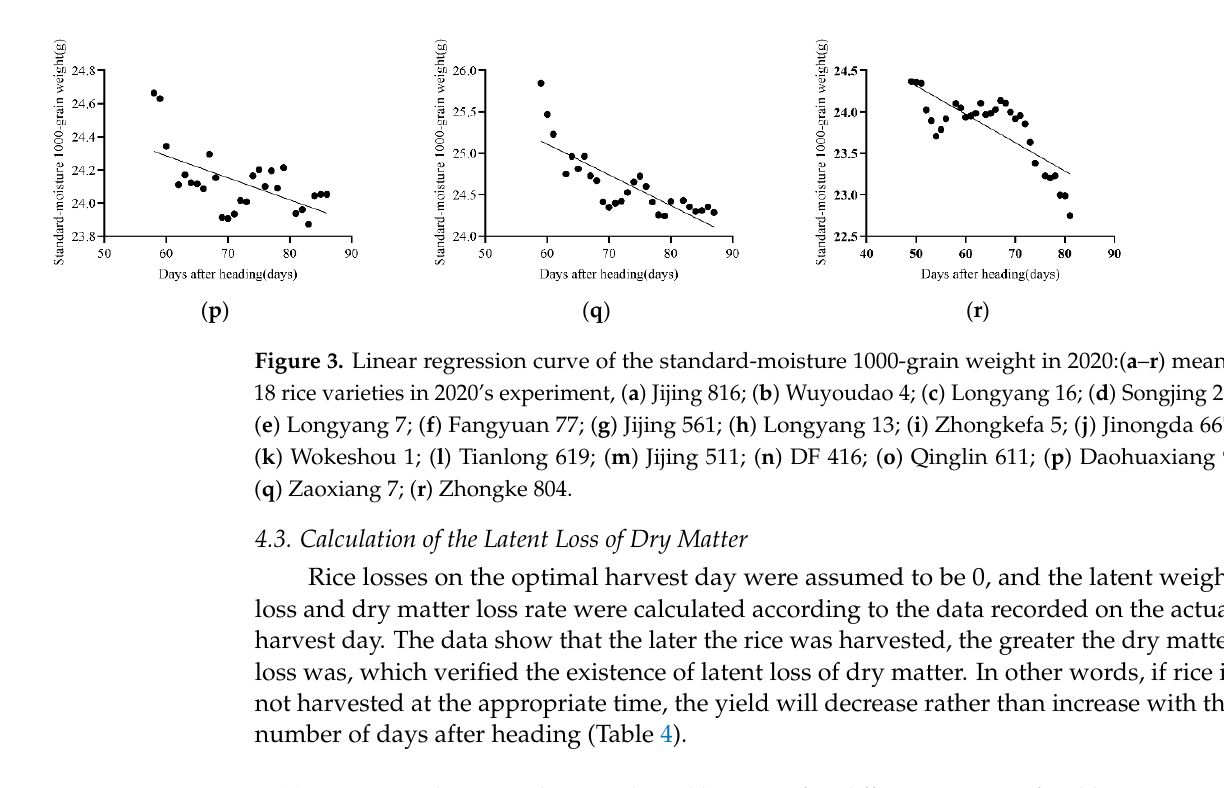
Table 4. Average dry matter loss weight and loss rate of 18 different varieties of paddies in 2020.